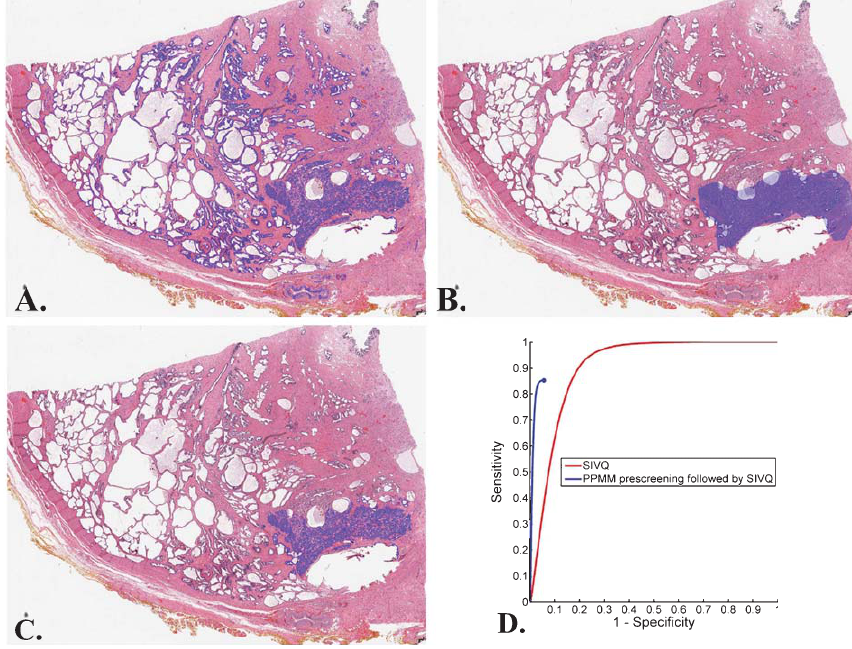
Fig. 3. SIVQ, PPMM, PPMM-SIVQ analysis of sample #2. Using SIVQ, a ring vector was selected to identify the prostatic epithelium. The resultant thresholded heatmap is shown in Panel A. Nearly all the epithelium was identified. The same specimen was then analyzed with PPMM. The resultant thresholded heatmap is shown in Panel B. PPMM identified nearly the entire tumor nodule. The algorithm cascade of PPMM followed by SIVQ was then used to analyze the specimens. The malignant epithelium within the majority of the tumor nodule was identified and annotated in Panel C. To quantitatively assess and compare the performance of SIVQ to PPMM-SIVQ, an ROC curve was generated and shown in Panel D (SIVQ is red, PPMM-SIVQ is blue). PPMM-SIVQ far exceeds the performance of SIVQ alone when compared over the range of specificities achieved by PPMM-SIVQ. (Colours are visible in the online version of the article;